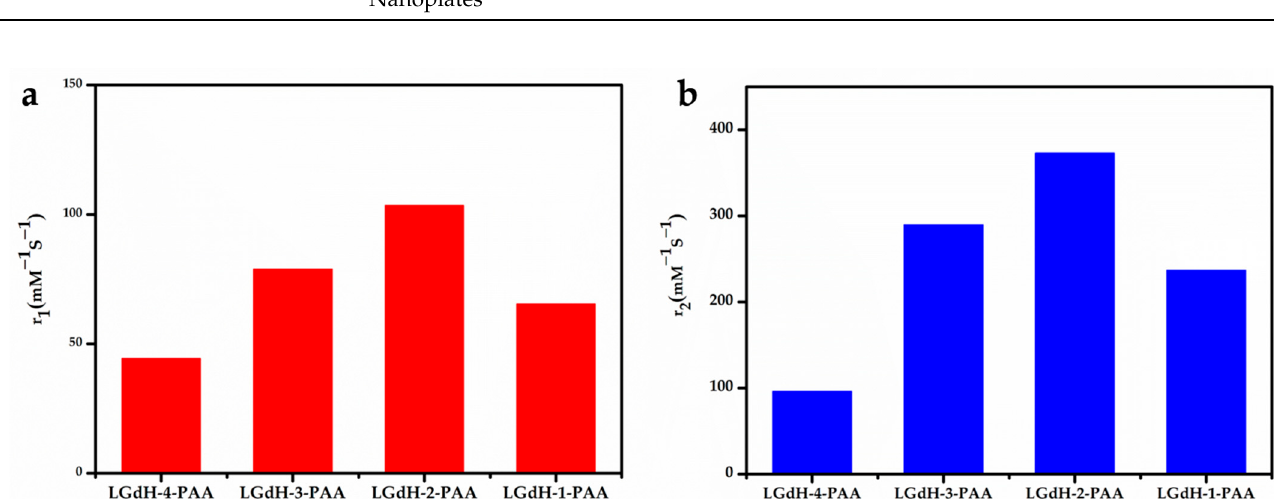
Figure 3. T 1 relaxivity plot ( a ), T 2 relaxivity plot ( b ), T 1 -weighted phantom images ( c ), and T 2 -weighted phantom images ( d ) of the samples as a function of the Gd 3+ concentration (at 3T). The values of the color-coded scale with no unit in ( b ) refer to the gray level of each pixel of images, ranging from 0 (black) to 255 (white); these could be regarded as the signal intensity, and a high value corresponds to a high signal intensity and a bright image.